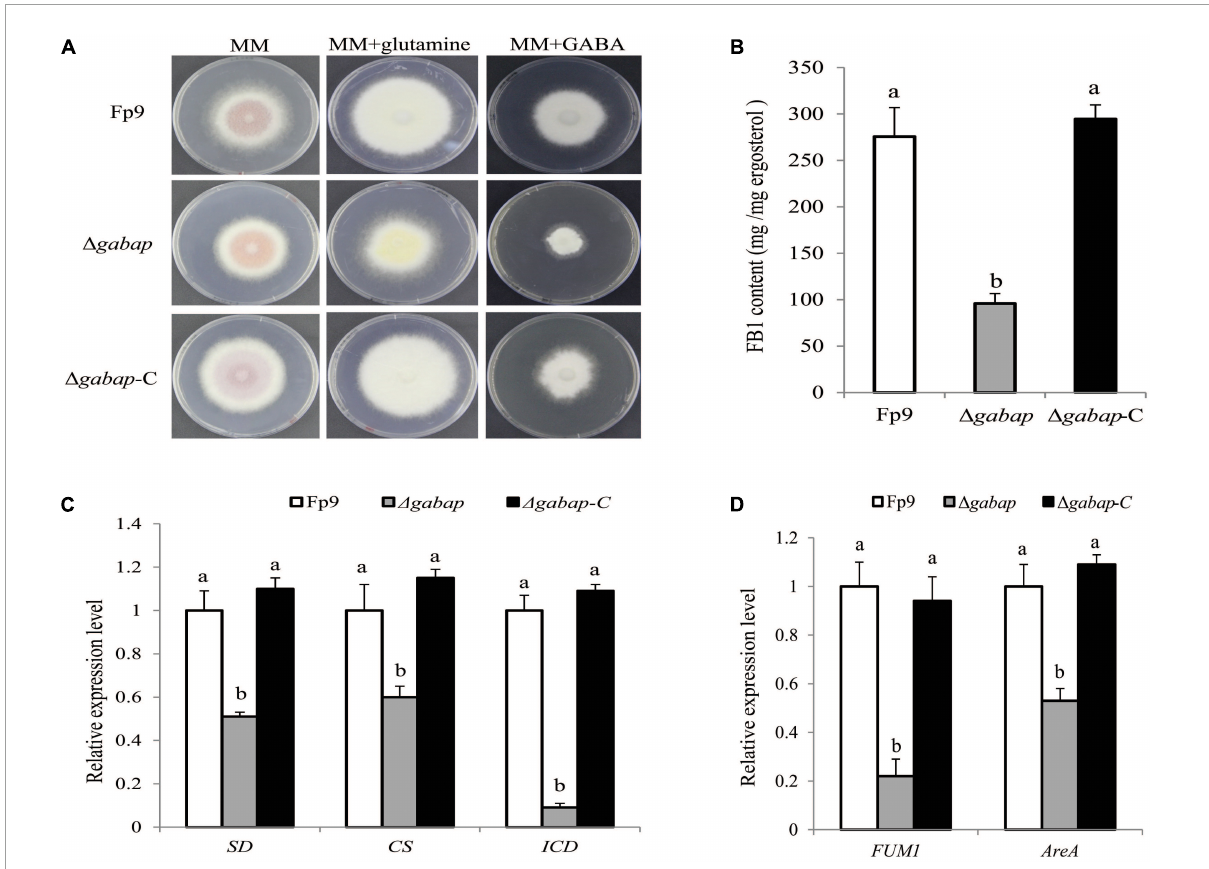
FIGURE5 Impact of GABAP on the TCA cycle and FB1 production. (A) Five-day-old colony of (cid:49) gabap mutant grown on minimal media (MM) containing 30 mM glutamine or GABA as the sole nitrogen source. (B) FB1 production of (cid:49) gabap cultured with 15-day-old rice kernels. (C) The expression levels of SD encoding succinate dehydrogenase, CS encoding citrate synthase and ICD encoding isocitric dehydrogenase of (cid:49) gabap grown in YEPD media for 72 h before switching to DL cultures for 3 h. Its relative expression level in wild-type strain Fp9 was arbitrarily set to 1. Different letters on bars indicated a significant difference ( p < 0.05) with three biological replicates. (D) The expression levels of FUM1 and AreA genes of (cid:49) gabap grown in YEPD media for 72 h before switching to DL cultures for 48 h. Its relative expression level in wild-type strain Fp9 was arbitrarily set to